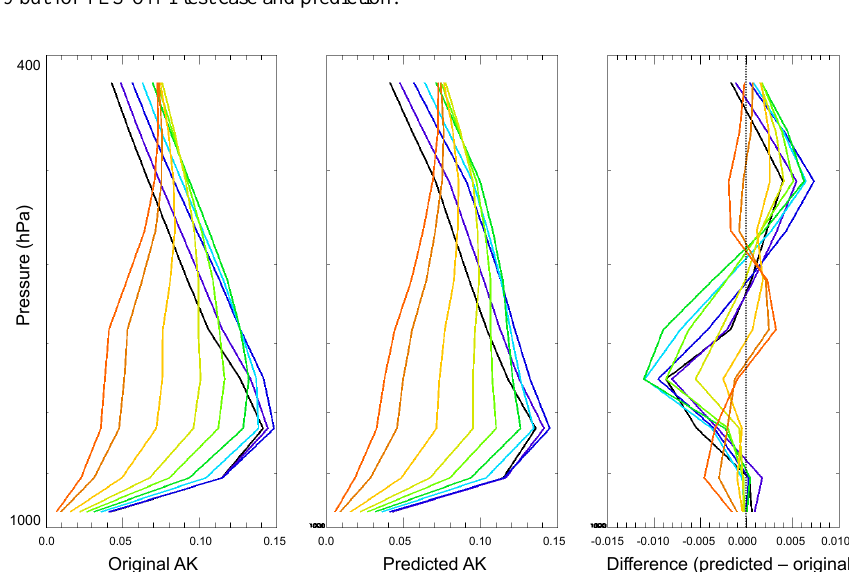
Fig. 12. Same as Fig. 10 but for TES-OMI test case AK and prediction. Figure 12. Same as Fig. 10 but for TES-OMI test case AK and prediction. computed for O 3 differences in ppb, for surface to 421 hPa